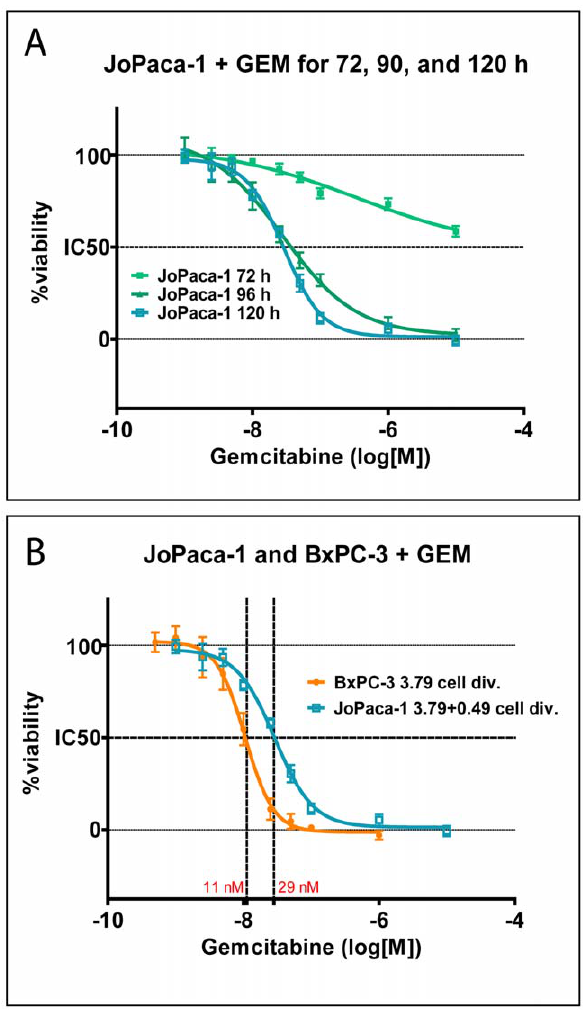
Figure 3. Response to gemcitabine dependent on time and growth rate. BxPC-3 and JoPaca-1 cells we treated with increasing concentrations of gemcitabine for 72, 96, and 120 hours. Cell viability was normalized to the non-treated controls. Data points represent averaged results of six replicate experiments with standard deviations indicated by error bars. A. Increasing incubation time with gemcitabine results in increased cytotoxicity for JoPaca-1. B. Cell viability was compared between 3.79 and 4.28 cell divisions for BxPC-3 and JoPaca-1, respectively. JoPaca-1 shows a higher tolerance towards gemcitabine than BxPC-3 even after extended incubation of 0.49 cell divisions. Figure 11C shows ALDH1 positive cells infiltrating a lymphatic vessel, while surrounding tumour cells are ALDH1-negative. CD133 + cells were stained in xenograft tissue slices at the apical membrane of ductal epithelial cells. Intracellular expression was detected in some cells. Cellular debris within the ductal lumen was strongly stained with CD133/1 (AC133) antibody. We could not detect CD133 in the primary tumour tissue (Fig. 11).